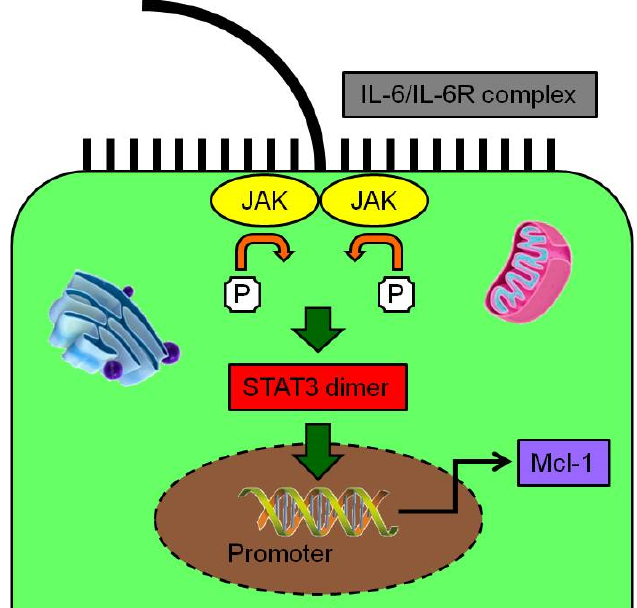
Figure 2. Schematic illustration of Il-6/STAT3 signaling. This pathway can be activated in malignant cholangiocytes and it consists in the binding of IL-6 to its receptor. This process promotes JAK with subsequent phosphorylation, activation, dimerization, and nuclear translocation of STAT3 in the form of STAT3 dimer. STAT3 upregulates Mcl-1 transcription, which play an important role in cellular